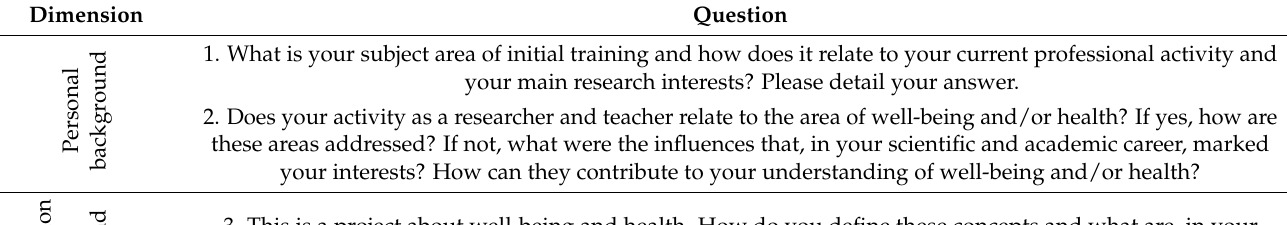
Table 1. Dimensions and questions of the interview script.